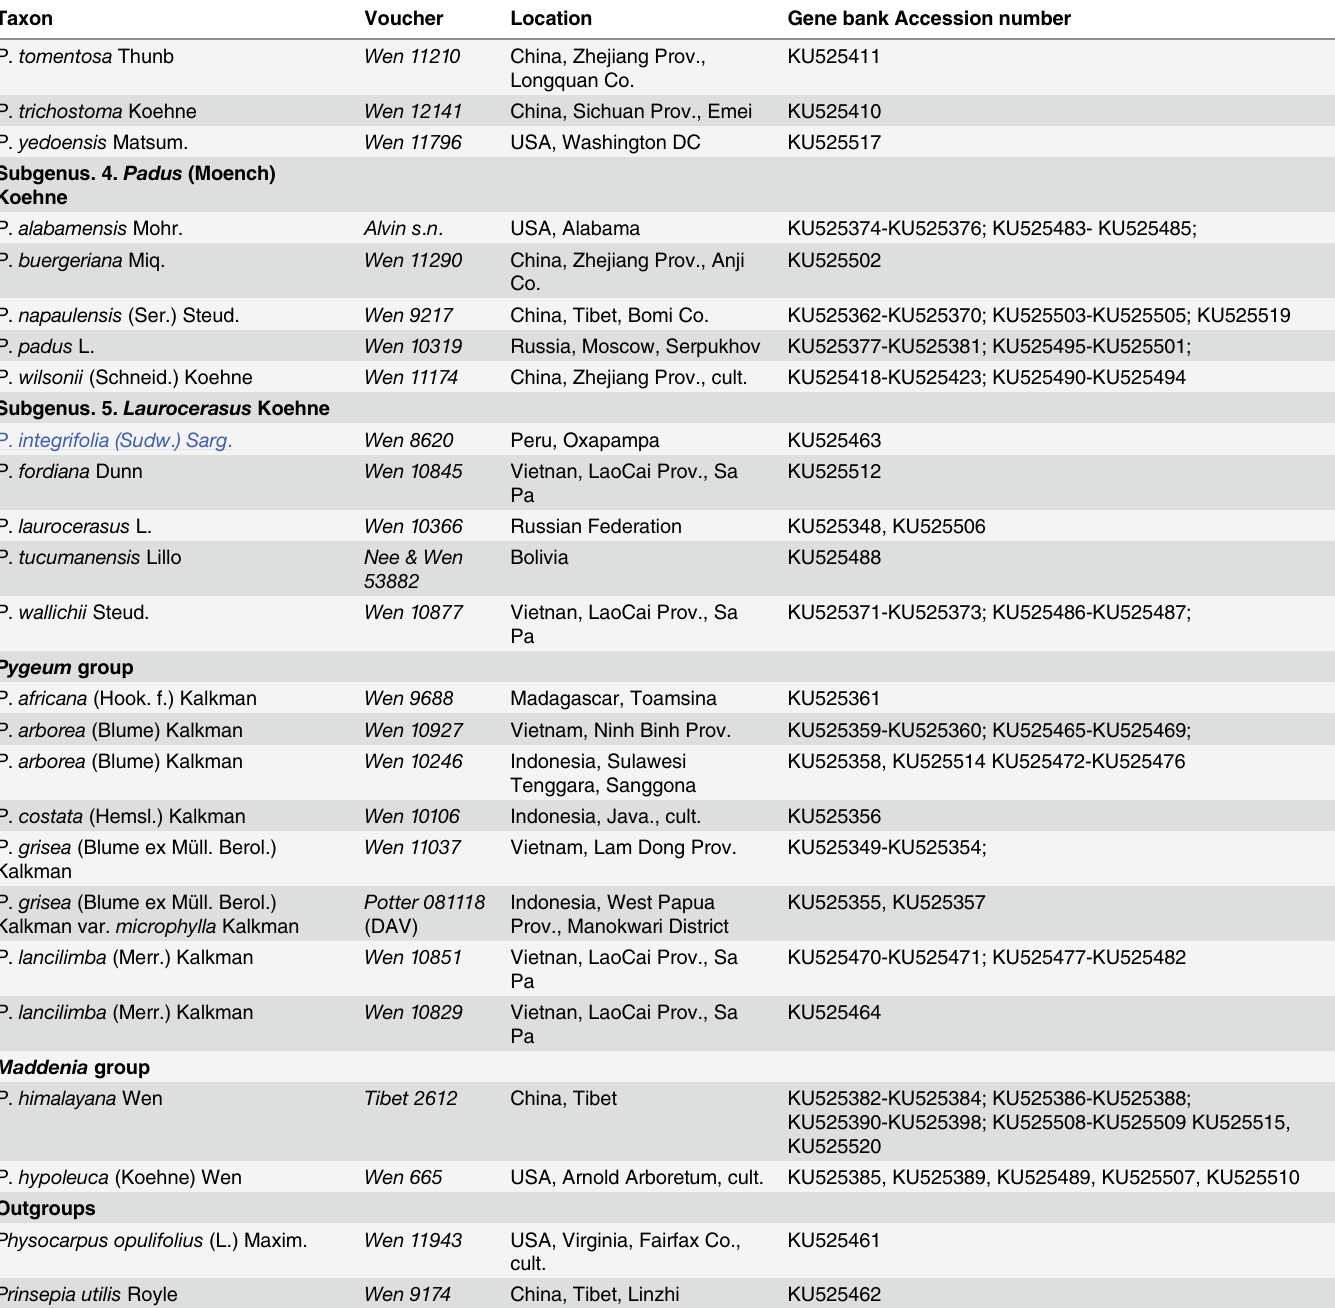
Table 2. Taxa and At103 gene GenBank accession numbers of Prunus and outgroups sampled for this study. All voucher specimens (except one col- lection Potter 081118 deposited in DAV) are deposited in the US National Herbarium